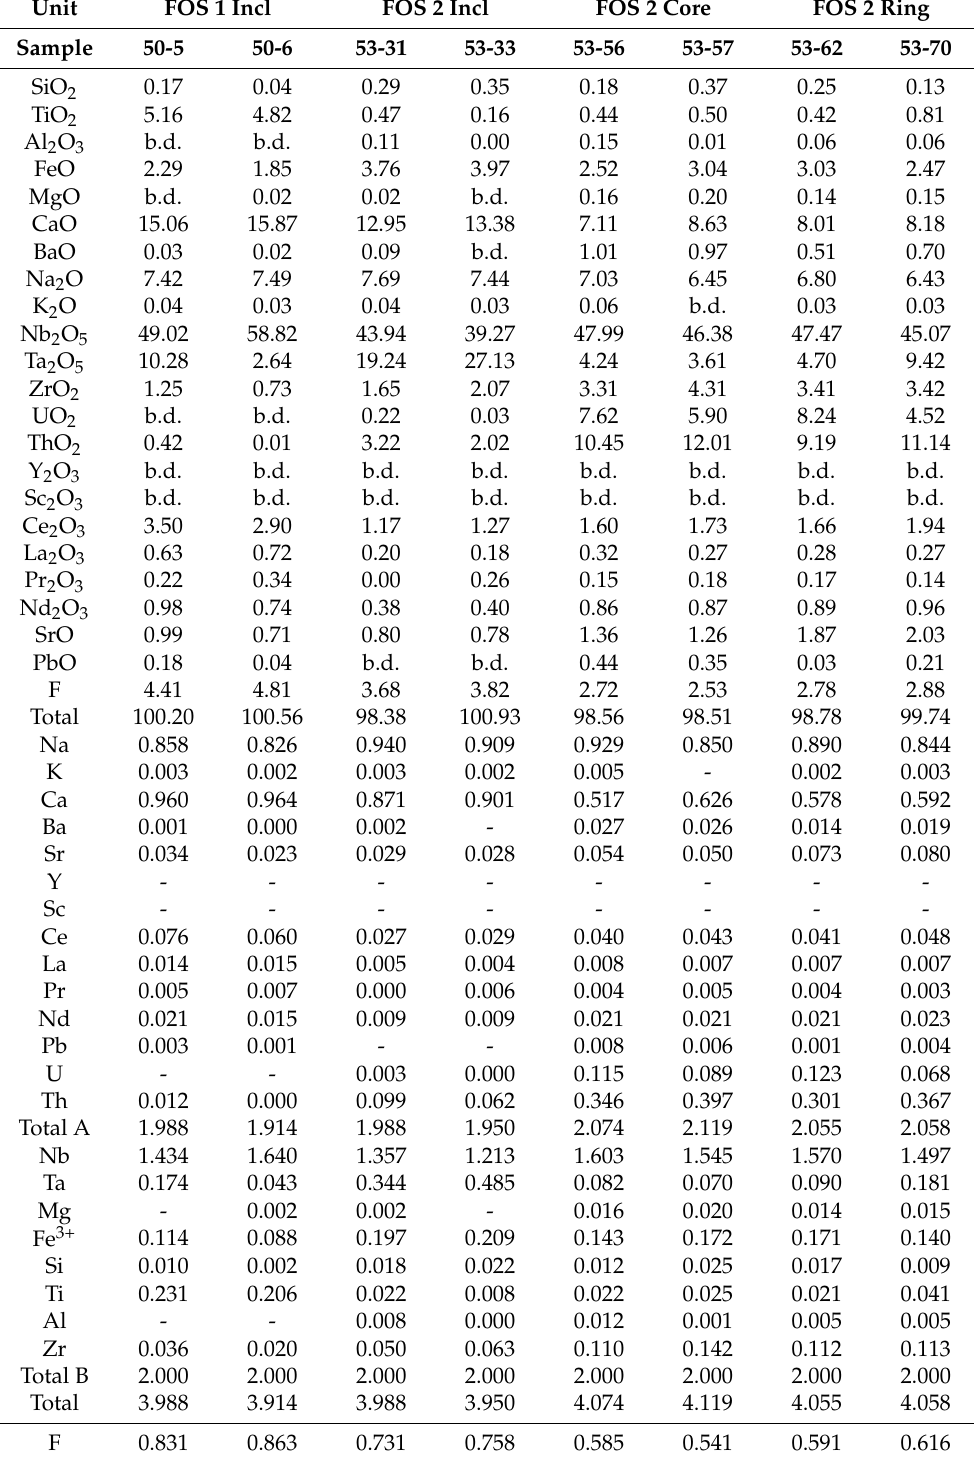
Table 5. Representative compositions of pyrochlore from phoscorites in the Arbarastakh massif. B.d. = below the detection limit. The structural formulae of pyrochlore are calculated for two cations